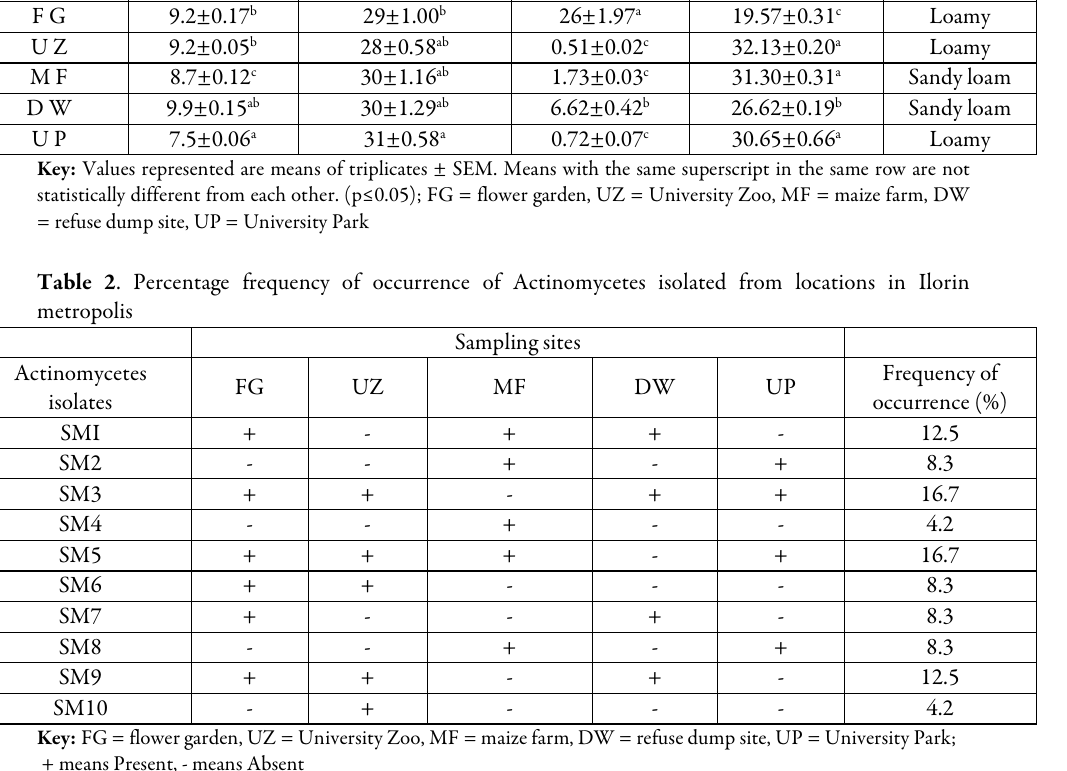
Table 1. Physicochemical characteristics of soils from different locations of Ilorin metropolis Location pH